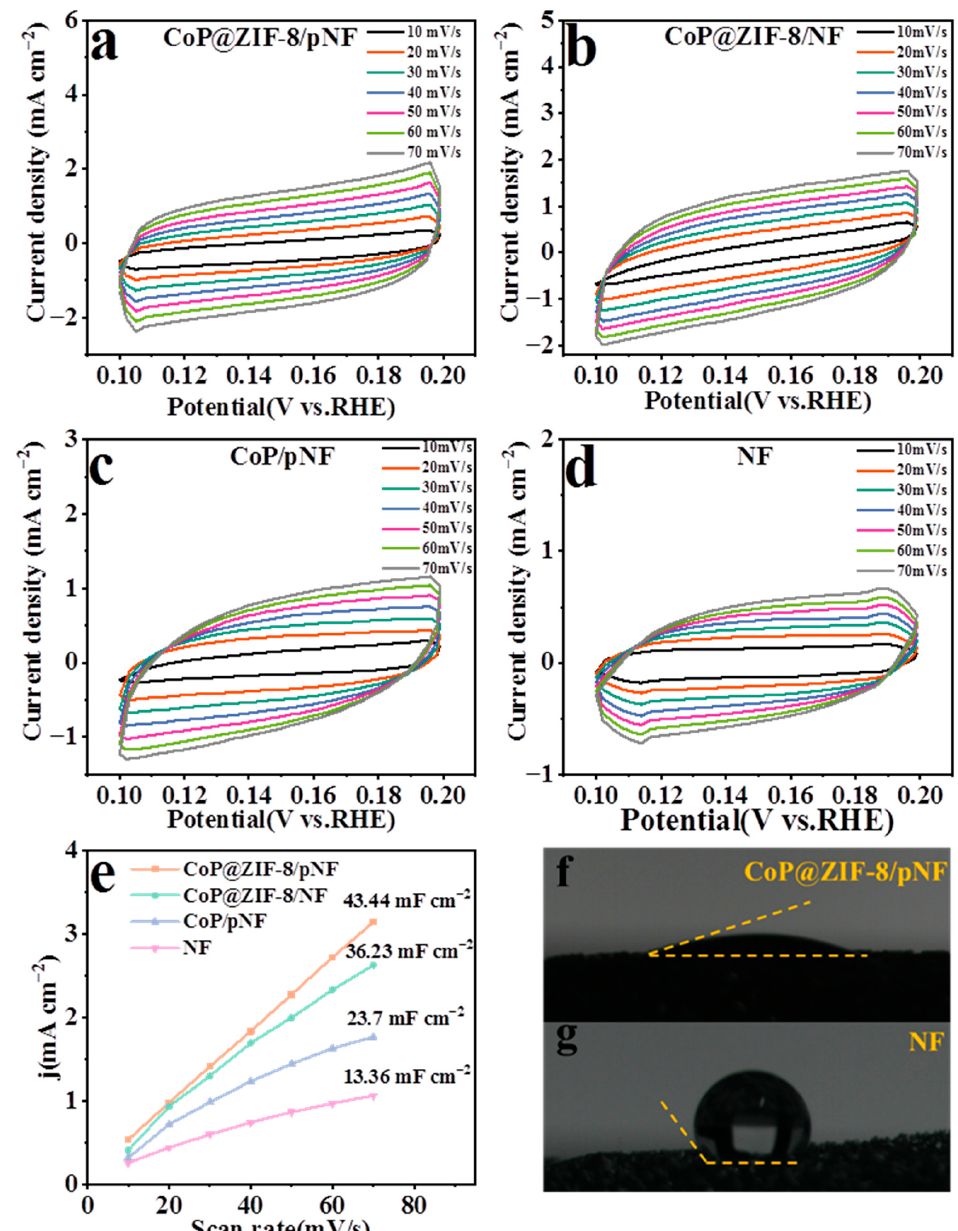
Figure 11. CVs at di ff erent scan rates between 0.1 and 0.2 V (vs. RHE) for CoP@ZIF-8/pNF ( a